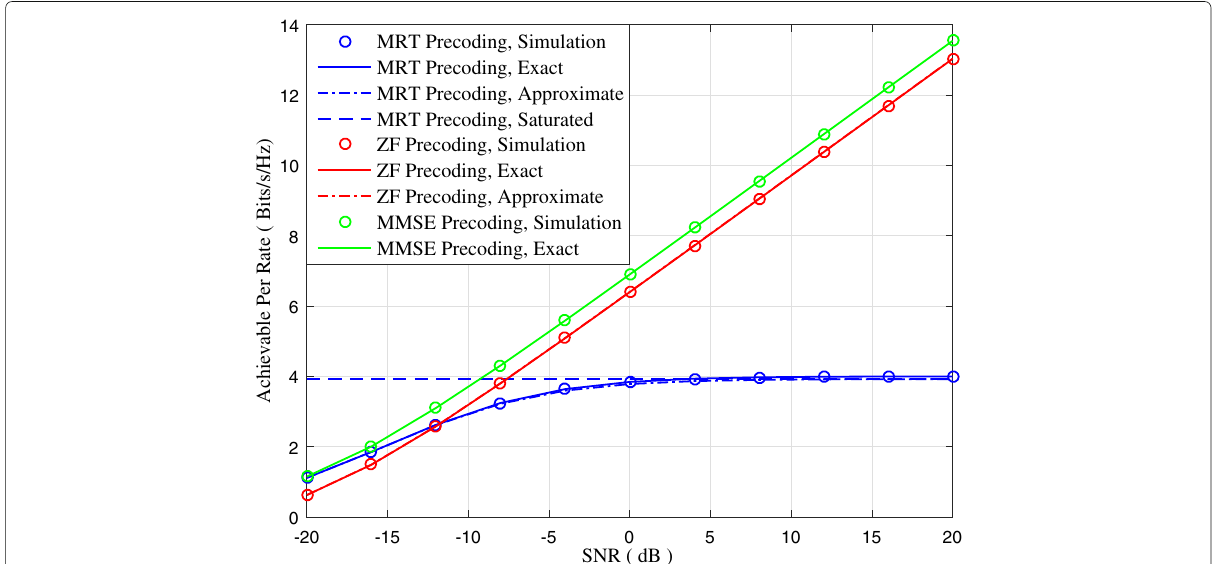
Fig. 2 Comparison of the achievable per rate of the k th user versus SNR for MRT, ZF, and MMSE precoding schemes. Results are shown for N t = 128 and K = 10